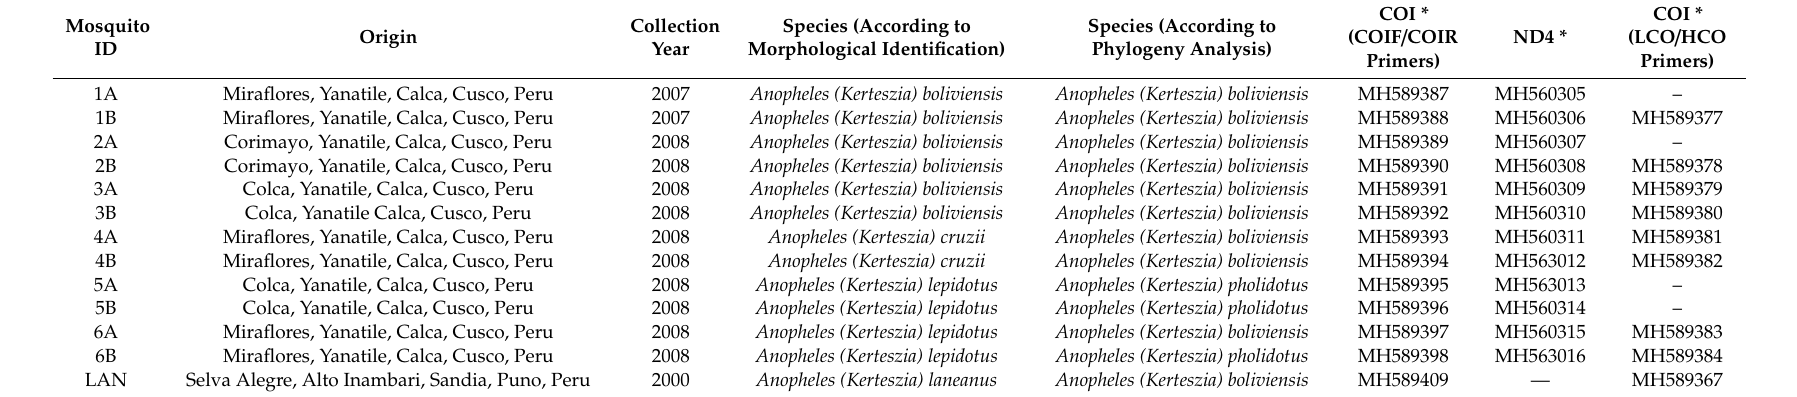
Table 1. Main features of the specimens from Peru used in this study and GenBank accession